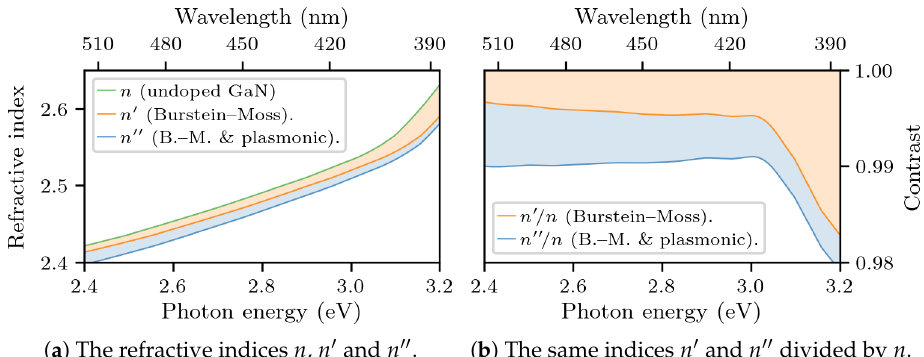
Figure 8. The refractive index n of undoped GaN (from [24]), as well as the decrease caused by the Burstein–Moss (orange area) and plasmonic effects (blue area), leading to the modified indices n (cid:48) and n (cid:48)(cid:48) (calculated from our model using the fitting parameters from ellipsometry: ∆ E bm = 0.059eV, ¯ h ω p = 0.278eV).